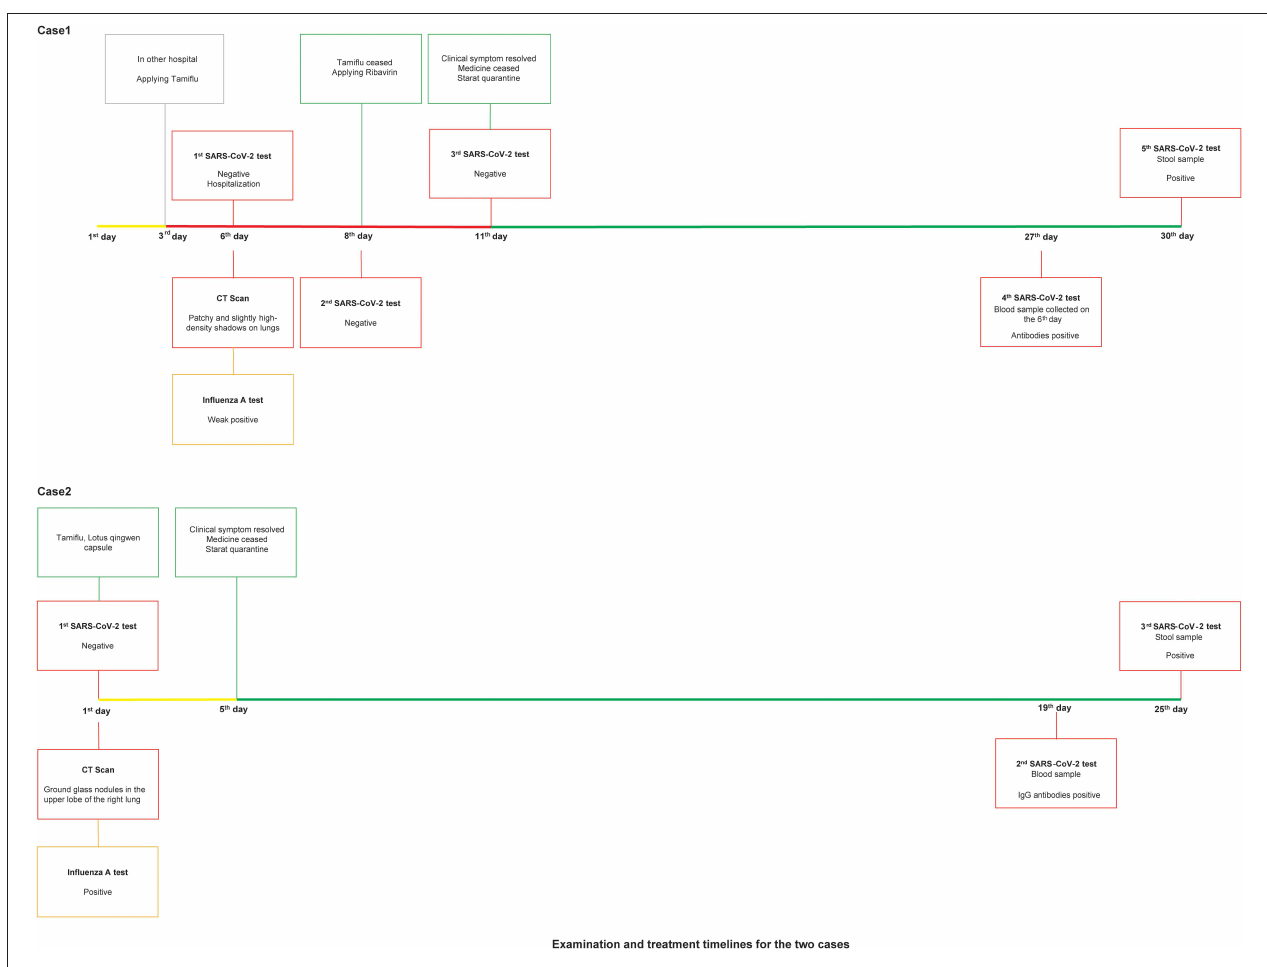
FIGURE 2 | Examination and treatment timelines for the two cases. Lines in different colors represent different clinical symptoms: yellow line stands for fever, red line stands for fever and dry cough, green line stands for